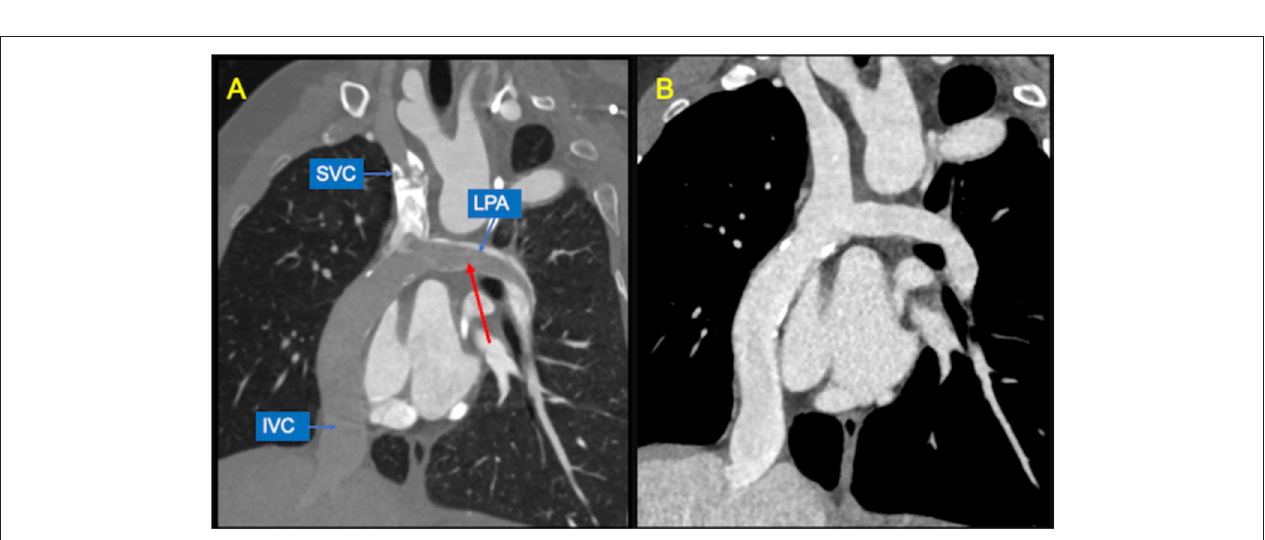
FIGURE 6 | Use of CCT in the acute setting. (A) contrast-enhanced axial image shows early post-operative left pulmonary artery thrombosis with a filling defect extended from the cavo-pulmonary anastomosis to the left hilum (red arrow). (B) CMR axial SSFP view performed 2 months after surgical reintervention demonstrates vessel patency.